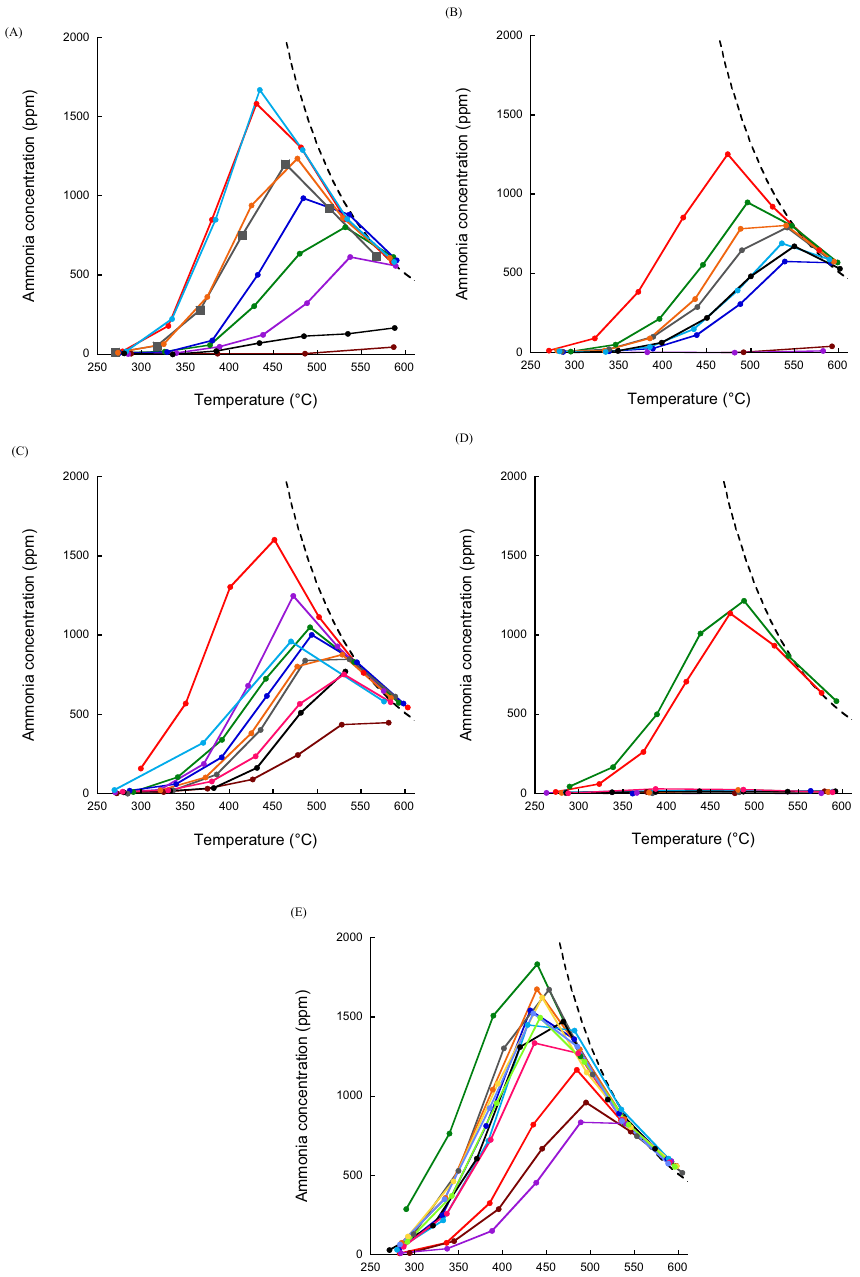
Figure 1. Concentrations of NH 3 synthesized using various Ru/MgO-MO x catalyst as functions of temperature. ( A ) The addition of alkali metals and alkaline earth metals. The black dotted line corresponds to the equilibrium conversion. Color code: red line: lithium, green line: sodium, blue line: potassium, brown line: rubidium, purple line: cesium, gray squares: magnesium, orange line: calcium, light blue line: strontium, black line: barium. ( B ) The addition of transition metals (period 4). The black dotted line corresponds to the equilibrium conversion. Color code: red line: scandium, green line: titanium, blue line: vanadium, brown line: chromium, purple line: manganese, gray line: iron, orange line: cobalt, light blue line: nickel, black line: copper. ( C ) The addition of transition metals (period 5 and 6 without lanthanides). The black dotted line corresponds to the equilibrium conversion. Color code: red line: yttrium, green line: zirconium, blue line: niobium, brown line: molybdenum, purple line: rhodium, gray line: palladium, orange line: silver, light blue line: rhenium, black line: iridium, pink line: platinum. ( D ) The addition of Lanthanides. The black dotted line corresponds to the equilibrium conversion. Color code: red line: lanthanum, green line: cerium, blue line: praseodymium, brown line: neodymium, purple line: samarium, gray line: europium, orange line: gadolinium, light blue line: terbium, black line: dysprosium, pink line: holmium, yellow line: erbium, light green: thulium, pale blue line: ytterbium. ( E ) The addition of p-block elements and zinc. The black dotted line corresponds to the equilibrium conversion. Color code: red line: aluminum, green line: silicon, blue line: phosphorus, brown line: sulfur, purple line: zinc, gray line: gallium, orange line: indium, light blue line: tin, black line: tellurium, pink line: bismuth. Reaction conditions are described in the “Methods”